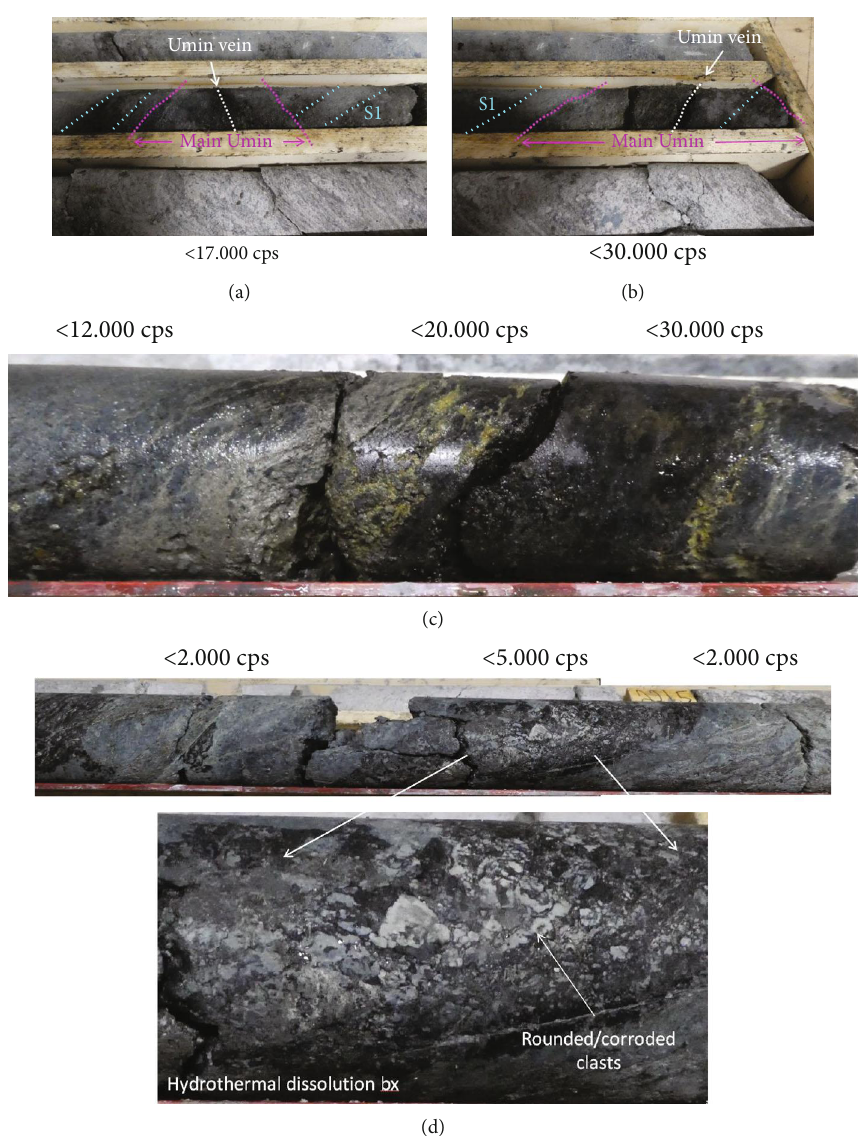
Figure 12: Drill hole ML-141. (a, b) Vein-related mineralization @216m. (c) Vein-related mineralization @220m. (d) Cataclastic-corrosion wear mineralized breccia @220